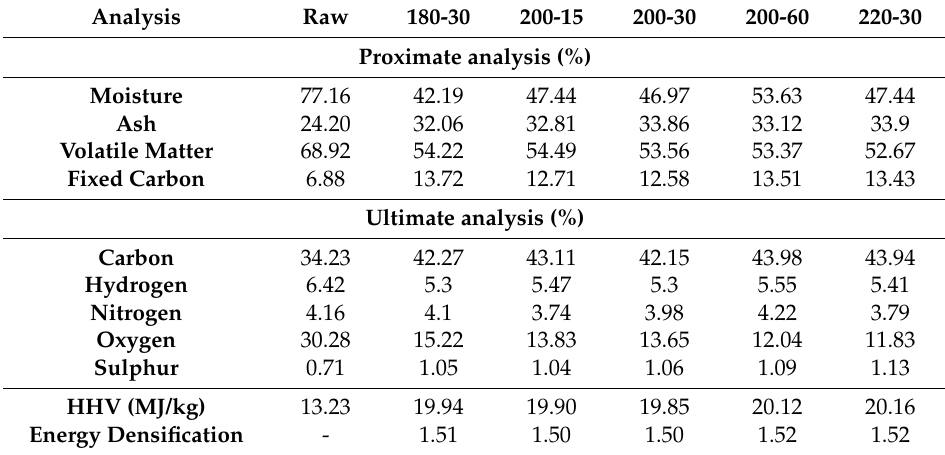
Table 2. Proximate, ultimate and heating value of solid hydrochar (dry basis). Product designations indicate temperature ( ◦ C) and time (min).